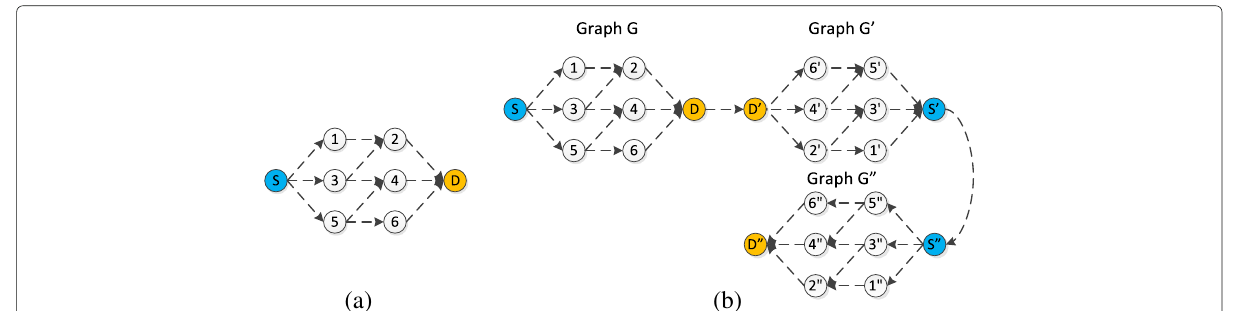
Fig. 4 Mirror image. a Original graph. b Mirror